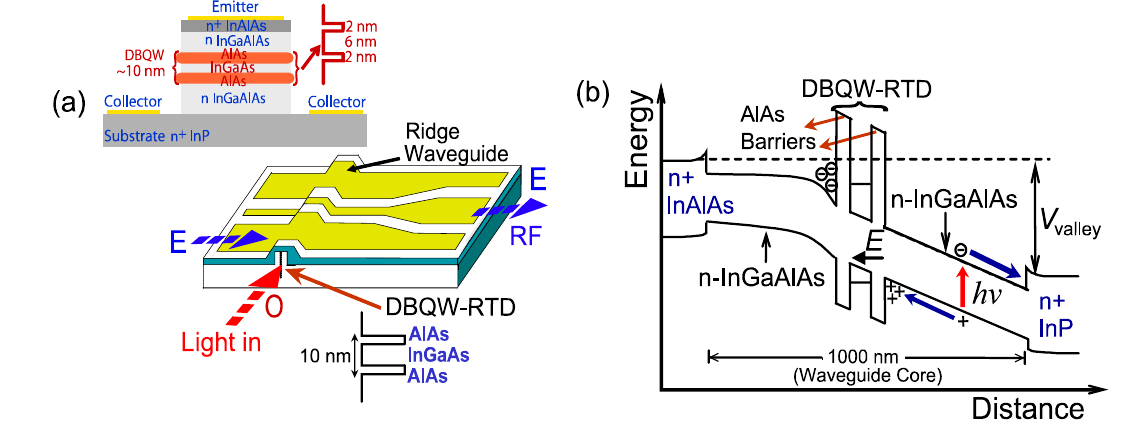
Figure 2. ( a ) Schematic diagram of RTD-PD device. The ridge waveguide dimensions were ~3 µm wide and 1 µm thick. Inset (on top) is shown the schematic diagram (not scaled) of the RTD epi-layer structure. ( b ) RTD-PD unipolar InAlAs-In energy